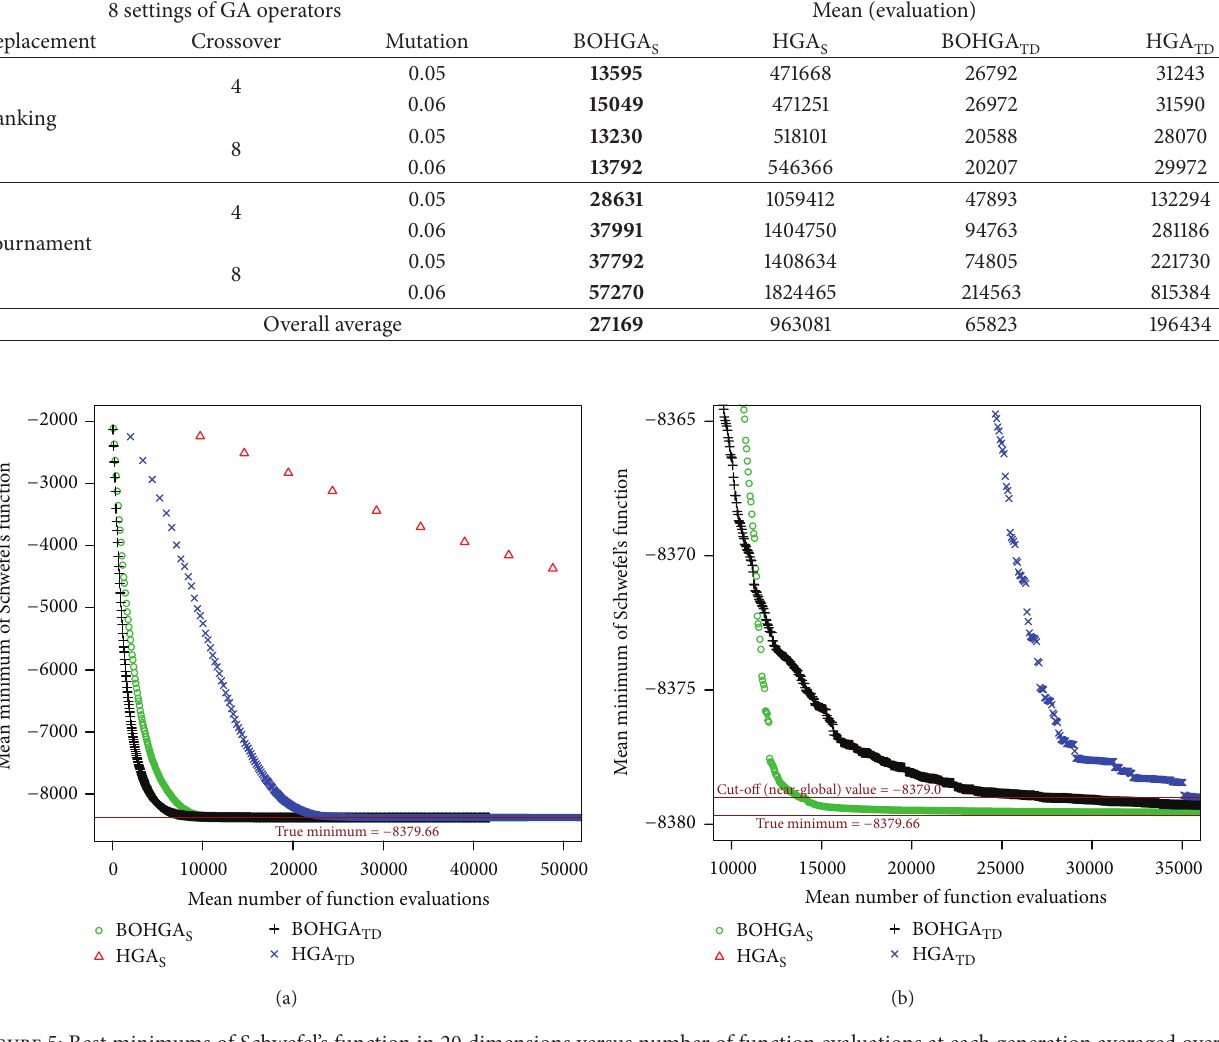
Figure 5: Best minimums of Schwefel’s function in 20 dimensions versus number of function evaluations at each generation averaged over 100 replications of the four MA methods under the GA setting (ranking replacement, four crossover points, and 0.05 mutation rate). (a) Overall view in a full scale; (b) highlighted view in an expanded